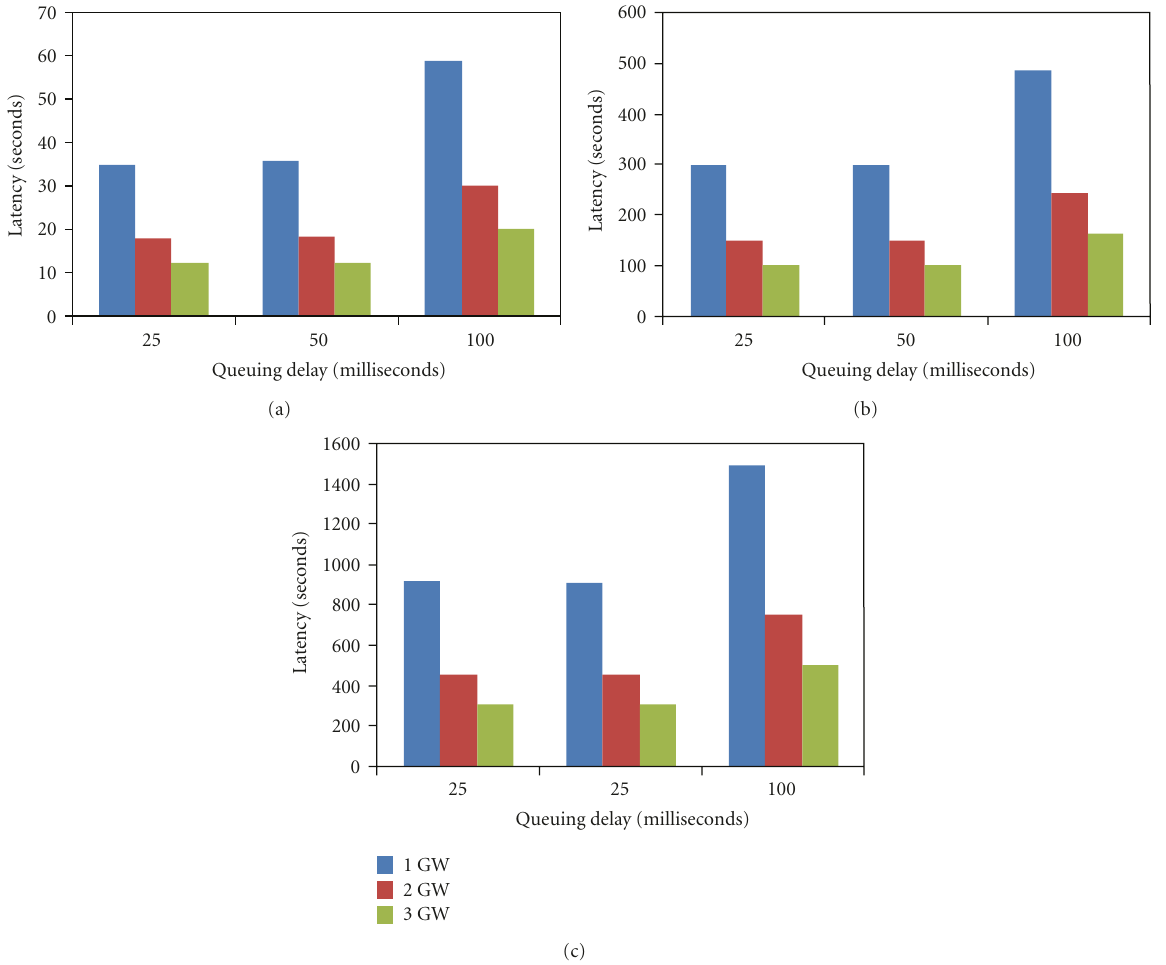
Figure 12: E ff ect of queuing delay on latency of file transfer (wired and wireless links bandwidths 100Mbps and 1.2Mbps) for file sizes (a) 5Kbytes, (b) 42Kbytes, and (c)